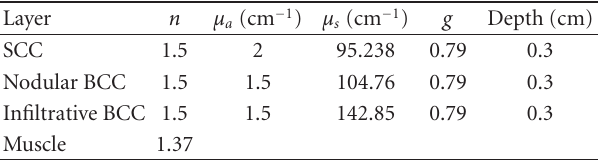
Table 1: Optical parameters used for each layer of the tissue sample model ( λ = 633 nm) and depth.